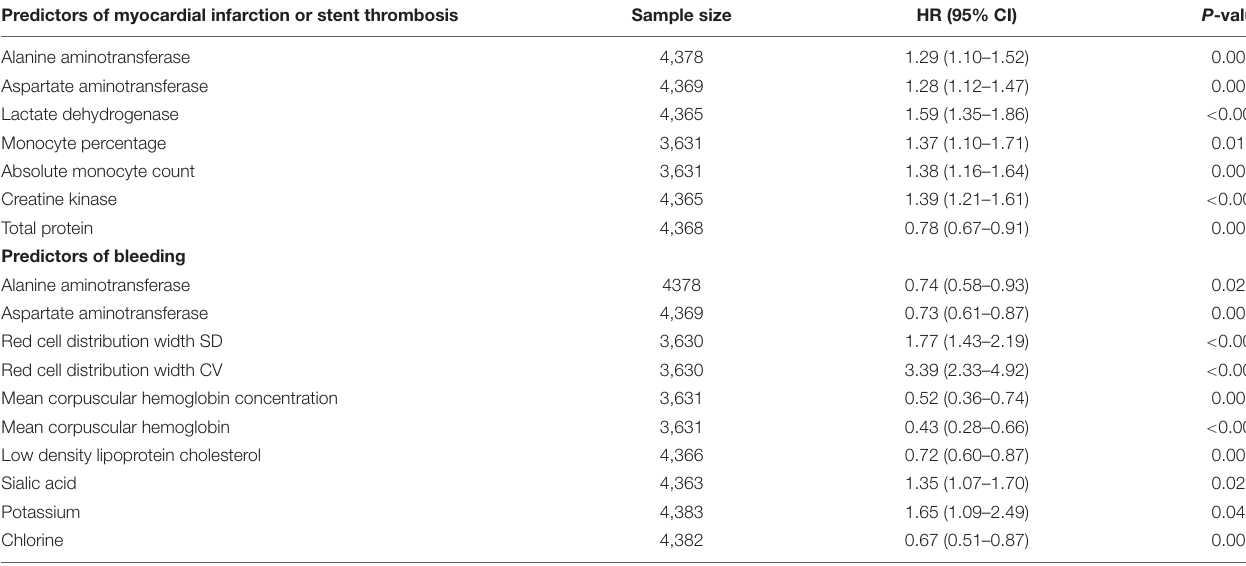
TABLE 2 | The candidate laboratory test biomarkers for incorporation into DAPT